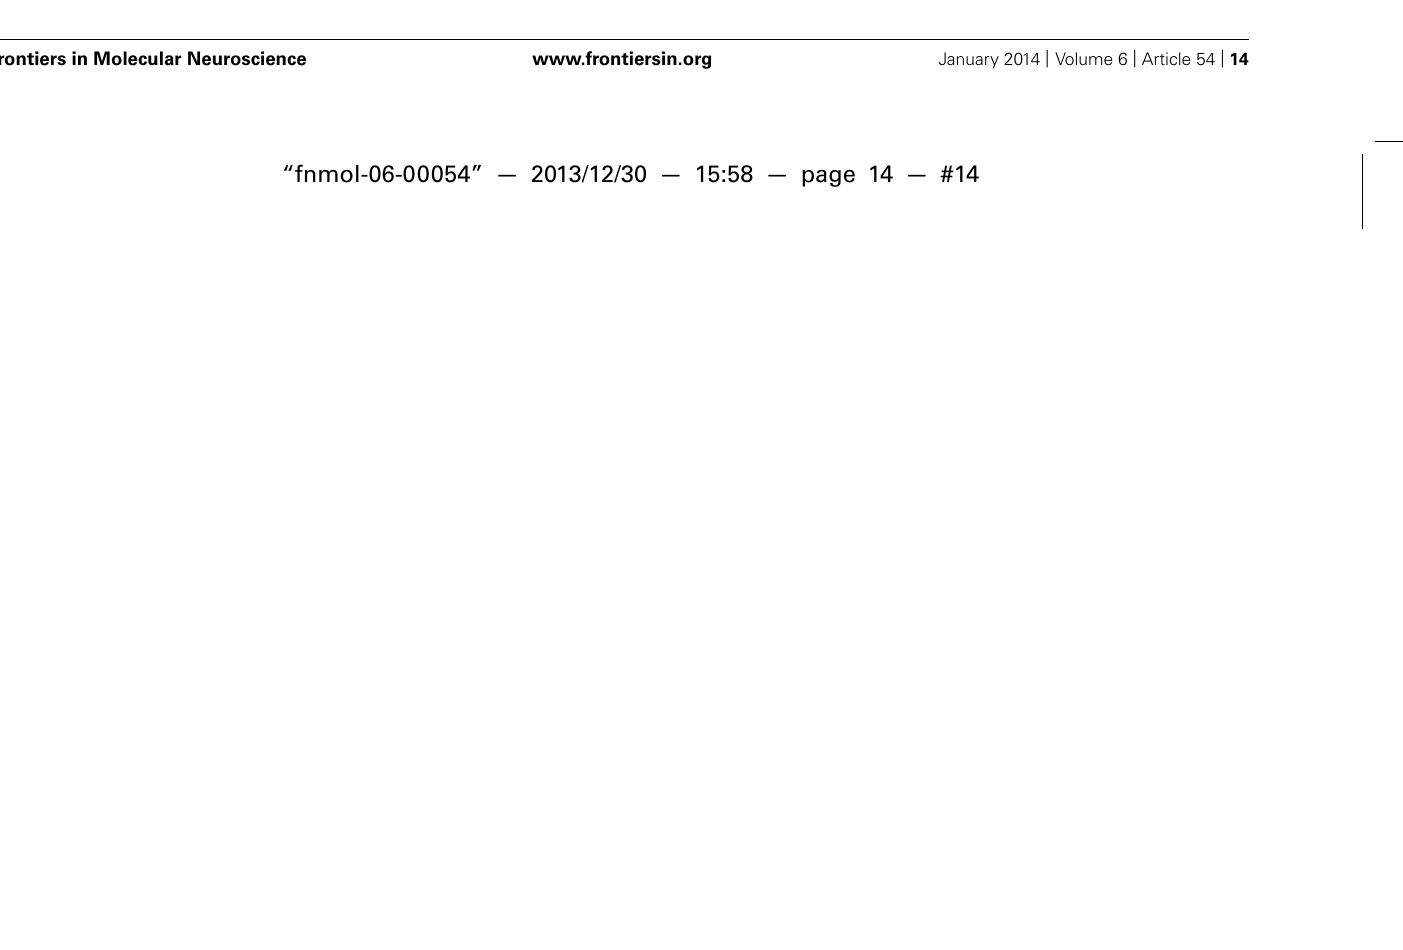
statistically different between 30 and 120 μ m from the soma (two-way ANOVA, p < 0.001; significant levels are not included for clarity). (C) Mean spine densities considering all values 60 μ m or more away from the soma (a distance at which the number of spines have reached a plateau). The number of spines in Tg2576 mice (10.5 ± 0.16, 50 dendrites from four animals) is significantly reduced compared to the wild-type (19.3 ± 0.47, 30 dendrites from three mice). Tg2576 injected with PTD4-PI3KAc exhibited an intermediate value (13.8 ± 0.18, 50 dendrites from six animals), suggesting that overactivation of PI3K partially counteracts the loss of spines in Tg2576